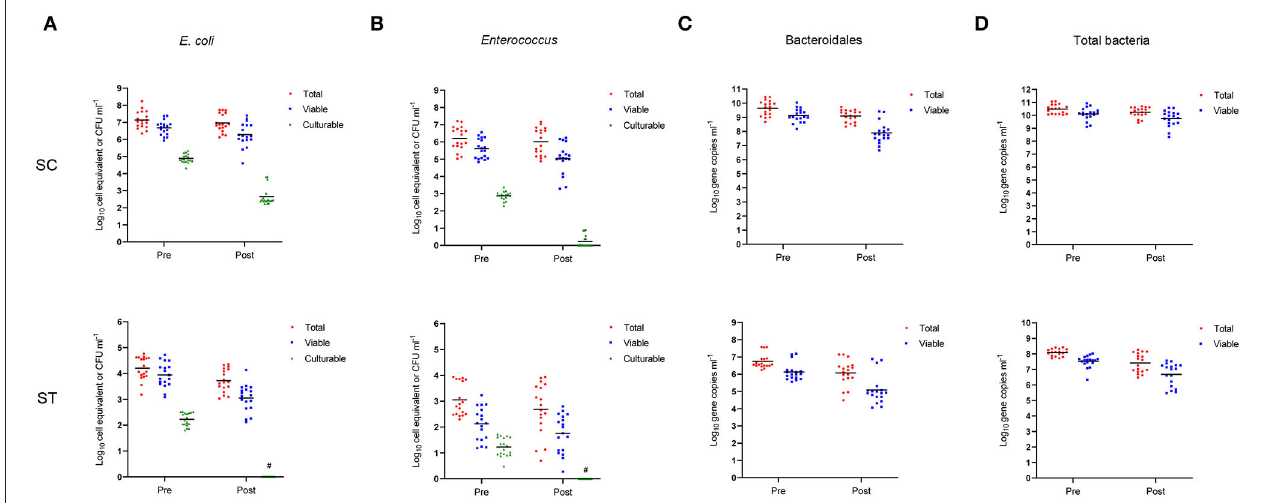
FIGURE 1 | Concentrations of E. coli , Enterococcus , Bacteroidales, and total bacteria before (Pre) and after (Post) chlorine disinfection in SC and ST. The samples collected bimonthly over a year were represented by individual data points, and the arithmetic means of the samples were indicated by horizontal lines. The concentrations of total, viable and culturable cells of (A) E. coli and (B) Enterococcus in each sewage treatment work were compared. The total and viable 23S rRNA gene copy numbers detected in PMA-qPCR assays were converted to numbers of cell equivalent by dividing the median numbers of gene copies per cell (log 10 cell equivalent ml − 1 ). The concentrations of culturable cells were determined using the plate counting method (log 10 CFU ml − 1 ). The concentrations of total and viable 16S rRNA gene copy numbers of (C) Bacteroidales and (D) total bacteria in each sewage treatment work (log 10 gene copies ml − 1 ) were shown. # Less than 1 colony was found per ml of